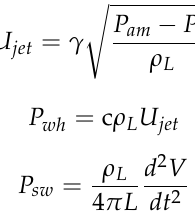
Figure 5. Cutaway of the cavitation device.